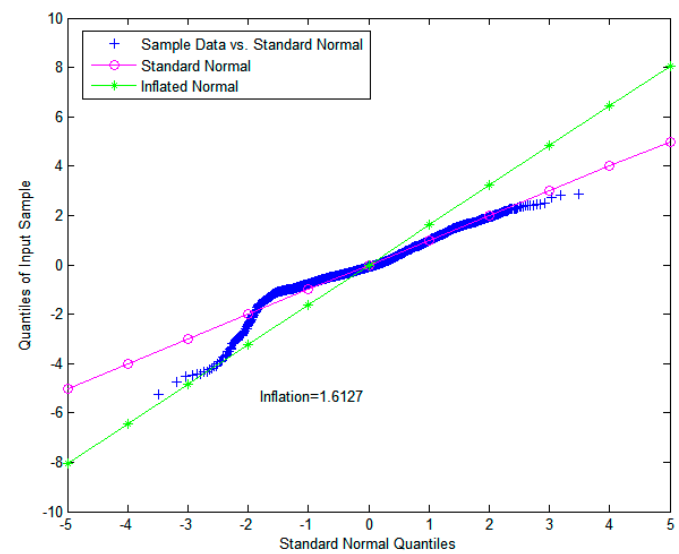
Figure 8. QQ plot for determination of the inflation factor using GPS raw data.